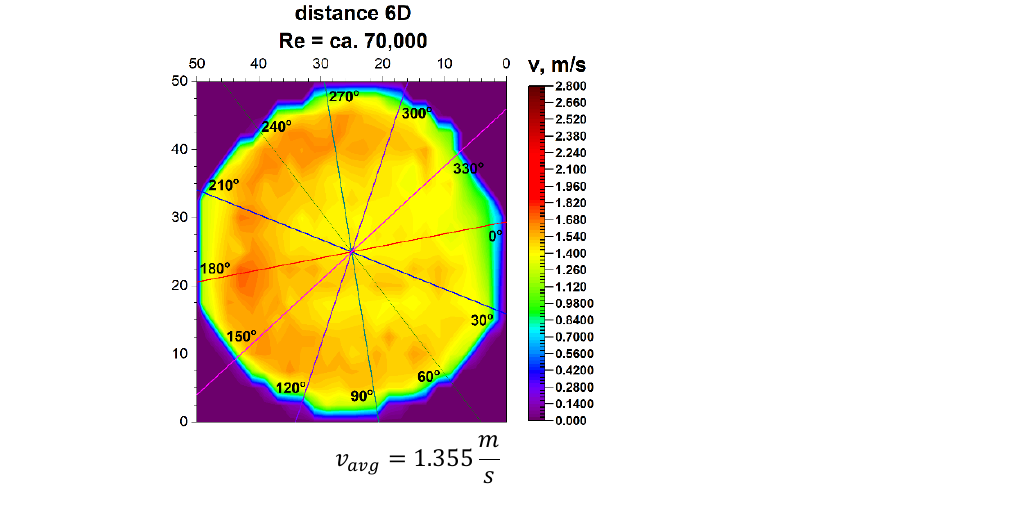
Figure 13. Projection on the velocity block the distance 6D from the disturbance with marked cross-sections for Re ≅ 70,000.